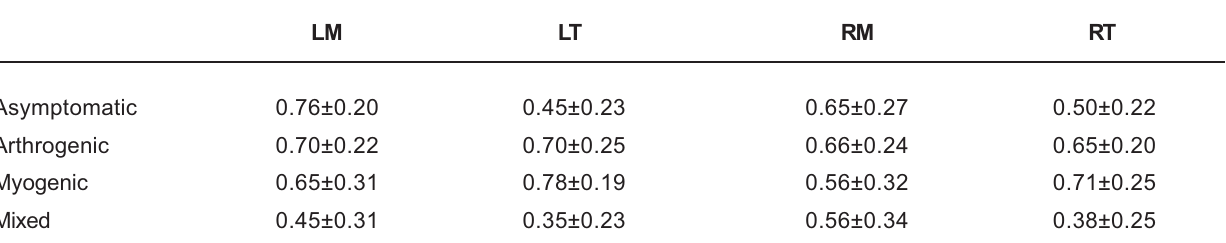
LM = Left Masseter; LT = Left Temporal; RM = Right Masseter; RT = Right